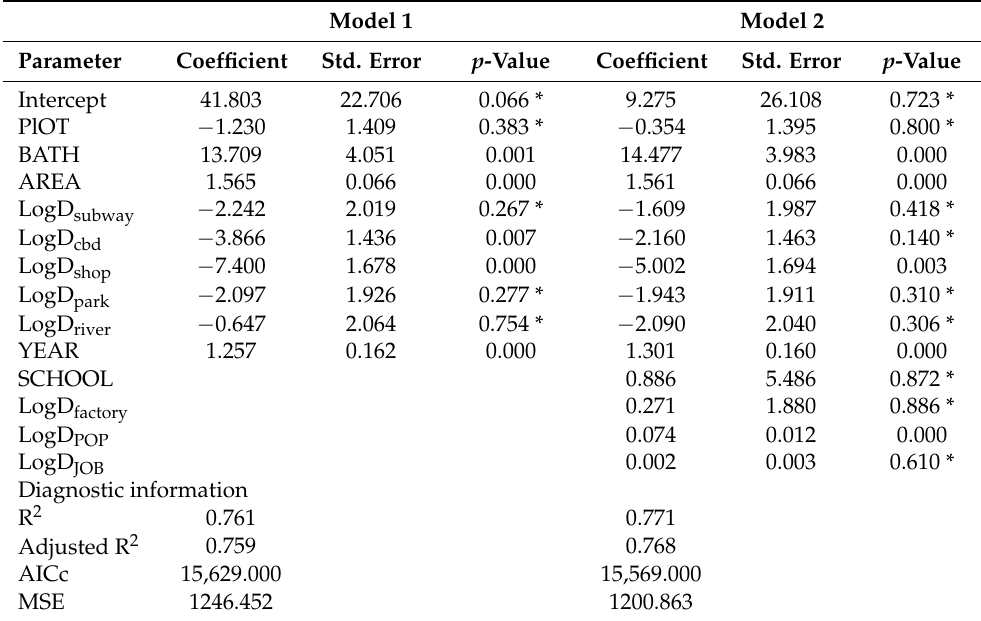
Table 2. Parameter estimates for the regression of residential land prices generated by